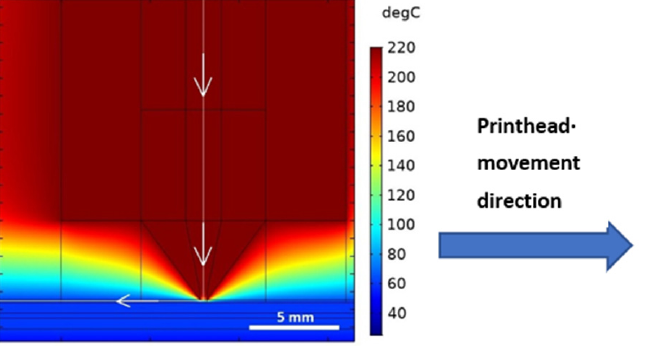
Figure 6. Temperature distribution at movement speed of 5 mm/s and at the time t = 5 s. Temperature distribution along the white line, where the white arrow denotes the direction of the x -axis is shown in Figure 7.